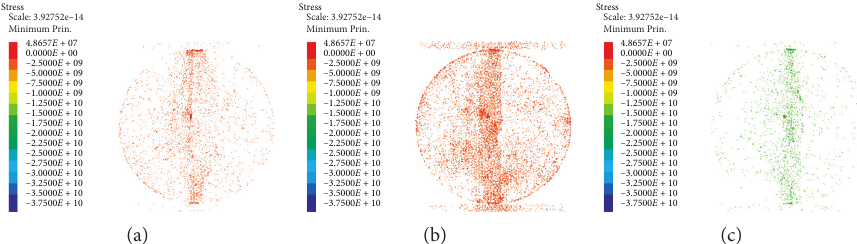
Figure 20: Loaded stress cloud with uneven parallel bedding models with different layer thicknesses. (a) 2 and 6. (b) 6 and 12. (c) 10 and